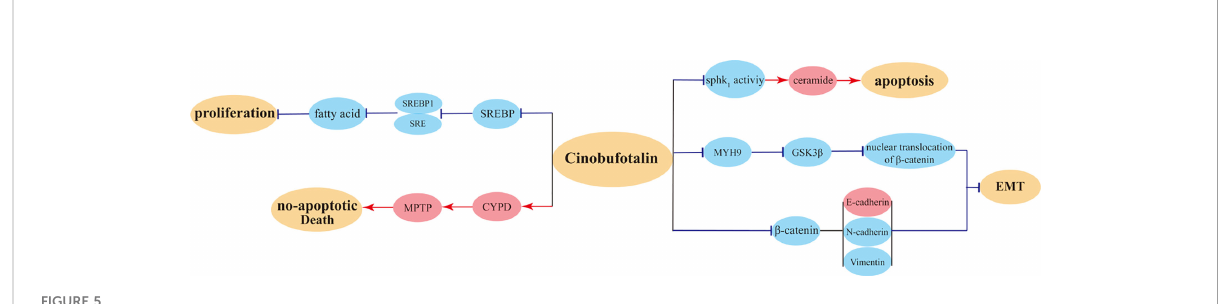
FIGURE 5 Cinobufotalin (CB) induced mainly anti-tumor